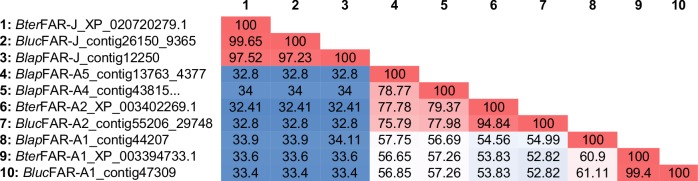
Protein sequence identities of bumble bee male marking pheromone (MMP)-biosynthetic FAR candidates.The colors indicate % identity (red: highest, white: medium, blue: lowest).